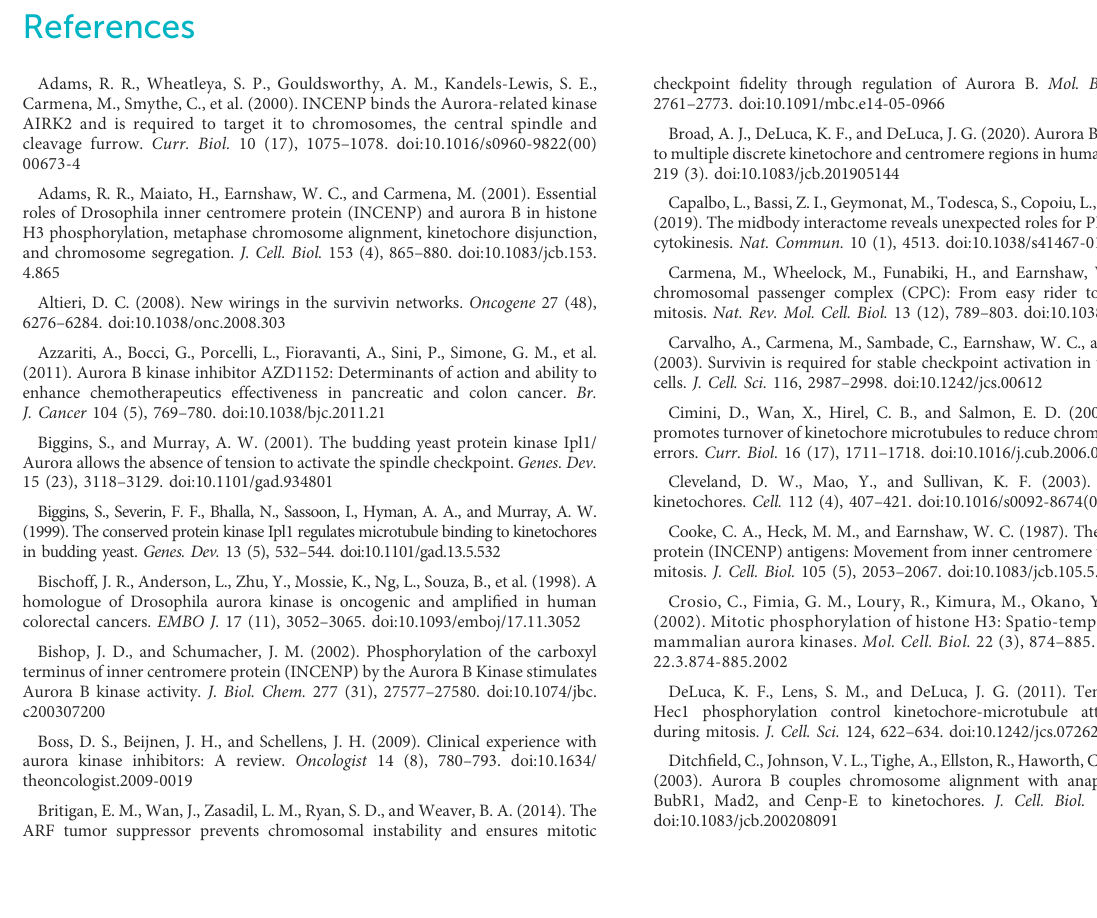
Figure S6. EB, BW, DS, and SC. generated fi gures. EB, AR,